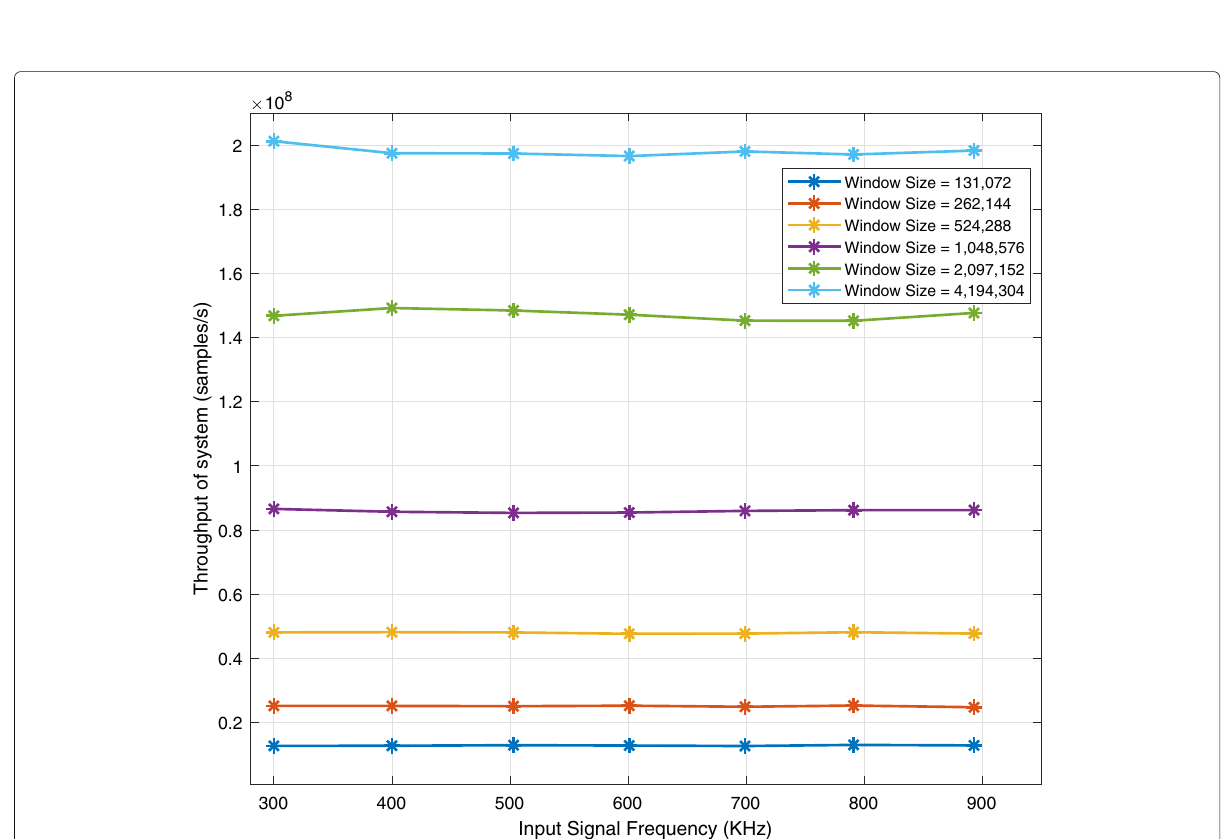
Fig. 7 System throughput versus input signal